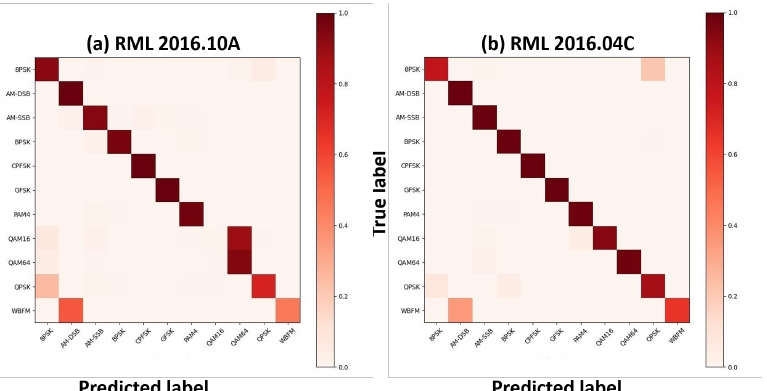
Figure 10. ( a ) Prediction performance of the proposed network on D 1 (RML2016.10A), ( b ) Prediction performance of the proposed network on D 2